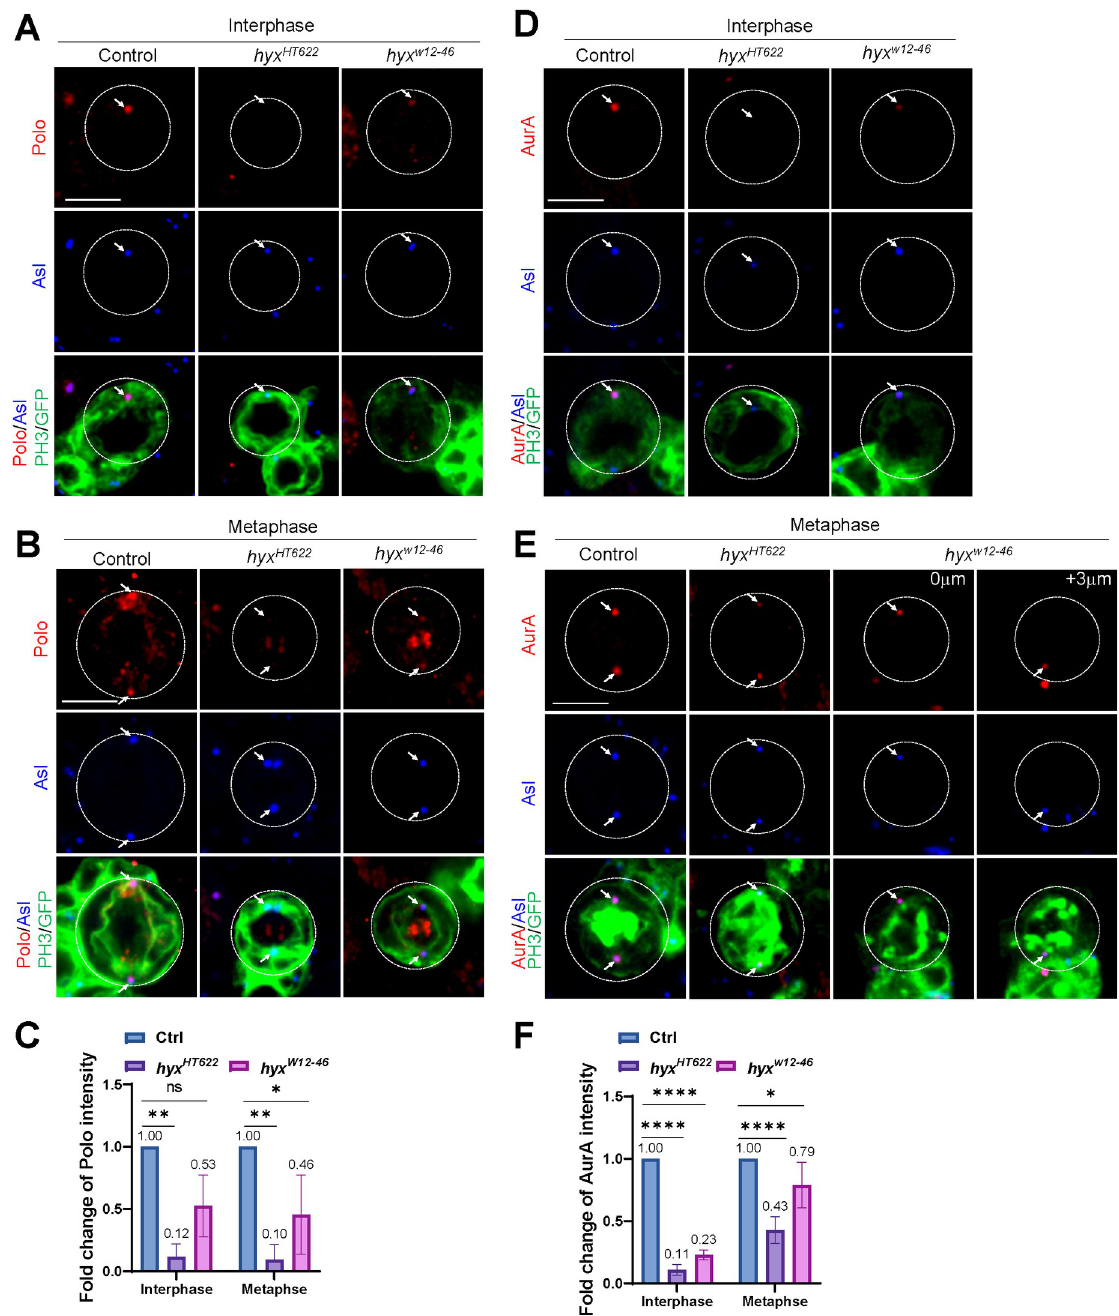
Fig 5. Hyx regulates the localization of centrosomal proteins Polo and AurA in NSCs. ( A ) Interphase NSCs from control (FRT82B) and hyx HT622 MARCM clones were labelled for Polo, Asl, GFP, and PH3. Polo delocalization/reduction: control, 5.8%, n = 52; hyx HT622 , 86.8%, n = 38; hyx w12-46 , 58.8%, n = 34. ( B ) Metaphase NSCs of control (FRT82B), hyx HT622 and hyx w12-46 MARCM clones were labelled for Polo, Asl, GFP, and PH3. Polo delocalization/reduction: control, 0%, n = 20; hyx HT622 , 80.0%, n = 10; hyx w12-46 , 75.0%, n = 12. ( C ) Quantification graph of the fold change of Polo intensity (with SD) in NSCs from A and B. Interphase: control, 1-fold, n = 41; hyx HT622 , 0.12 ± 0.11-fold, n = 38; hyx w12-46 , 0.53 ± 0.25-fold, n = 34. Metaphase: control, 1-fold, n = 20; hyx HT622 , 0.10 ± 0.12-fold, n = 10; hyx w12-46 , 0.46 ± 0.32-fold, n = 12. ( D ) Interphase NSCs from control (FRT82B; n = 36) and hyx HT622 ( n = 39) MARCM clones were labelled for AurA, Asl, GFP, and PH3. ( E ) Metaphase NSCs of control (FRT82B; n = 22) and hyx HT622 ( n = 18) MARCM clones were labelled for AurA, Asl, GFP, and PH3. ( F ) Quantification graph of the fold change of AurA intensity (with SD) in NSCs from D and E. Interphase: control, 1-fold, n = 36; hyx HT622 , 0.11 ± 0.04-fold, n = 39; hyx w12-46 , 0.23 ± 0.04-fold, n = 20. Metaphase: control, 1-fold, n = 22; hyx HT622 , 0.43 ± 0.11-fold, n = 18; hyx w12-46 , 0.79 ± 0.18-fold, n = 8. Cell outlines are indicated by white-dotted lines. Arrows point at the centrosome in A-E.